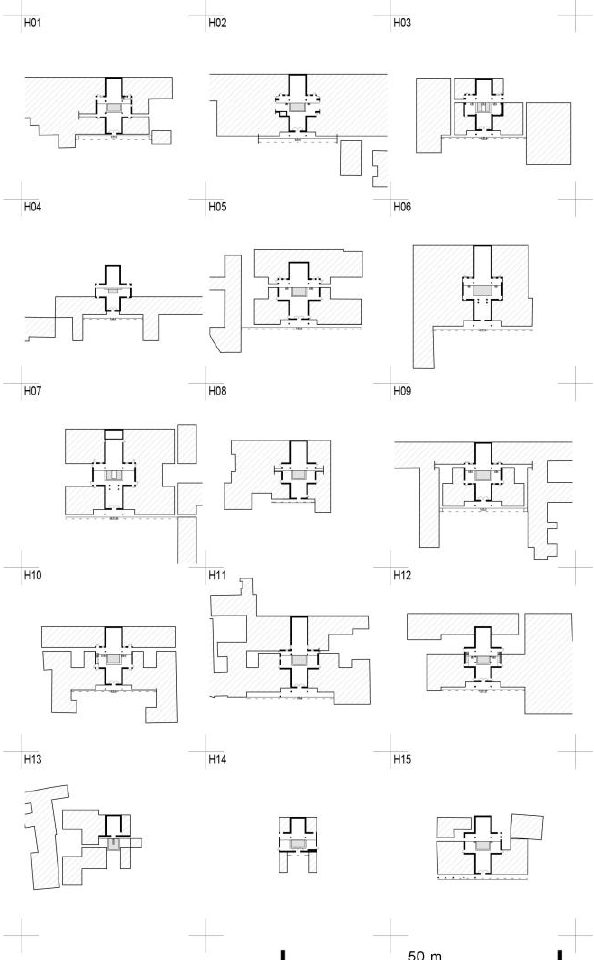
Figure 12. Comparative schemes of the halls' layout. Elaboration by the first